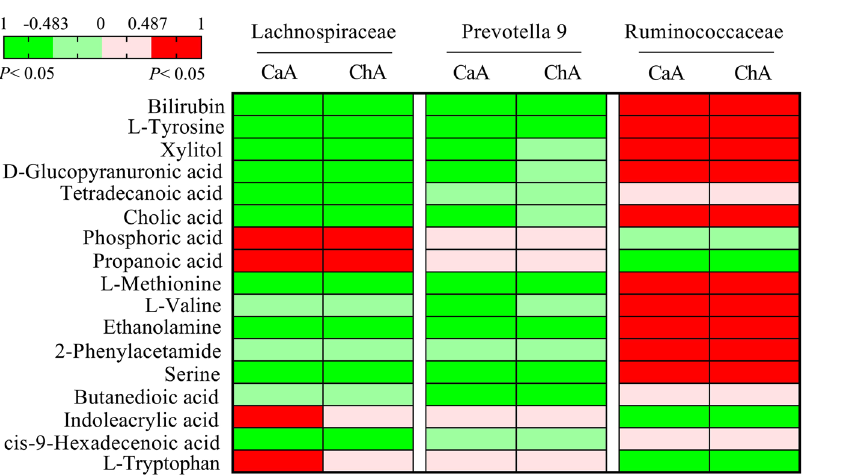
Figure 7. Heatmap with color gradients related to correlation coefficient between the variables. A red cell represents a significant correlation between the corresponding metabolite and microbiota component; green represents a significant anticorrelation between the variables; and other cells indicated no significant correlation. The correlation coefficients were assessed in CaA (control, DEN and DEN + CaA) and ChA (control, DEN and DEN + ChA) group,